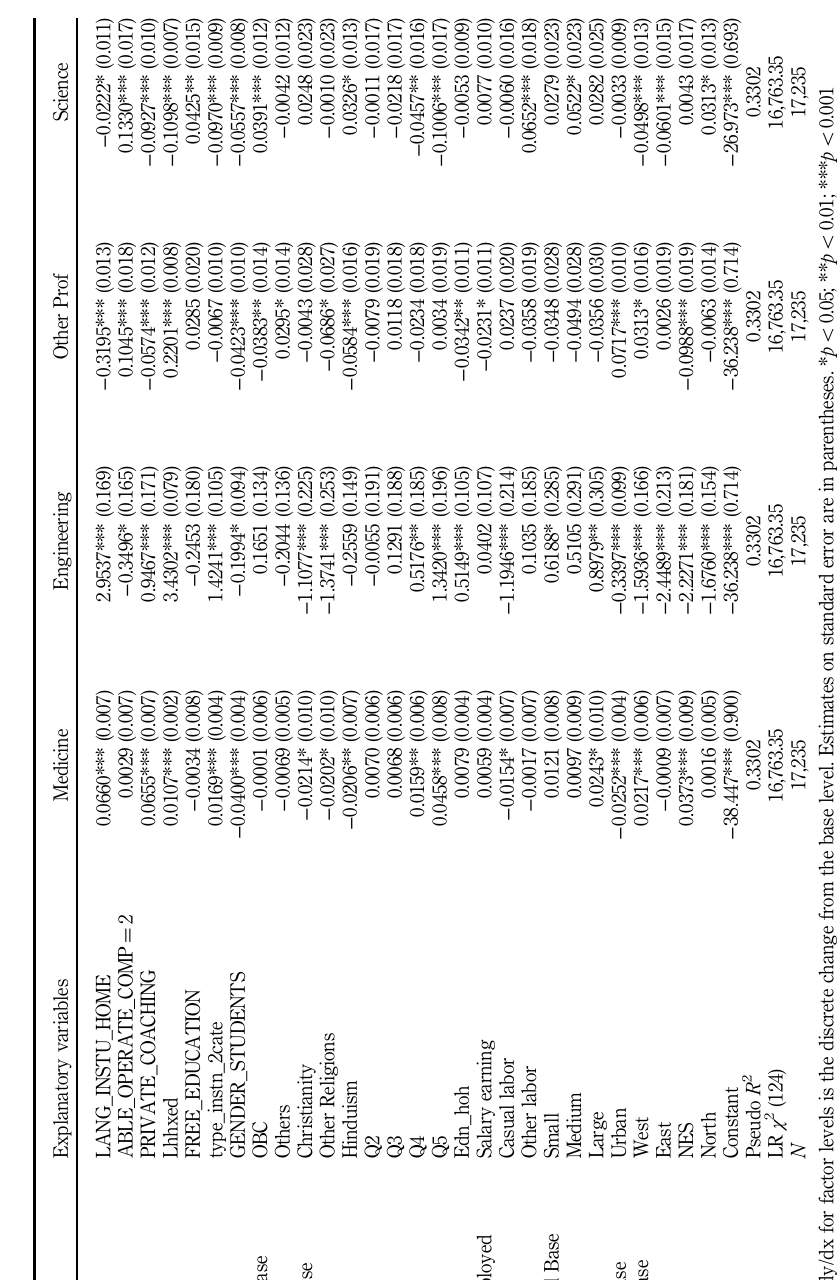
Table IV. Results of the determinants of college major